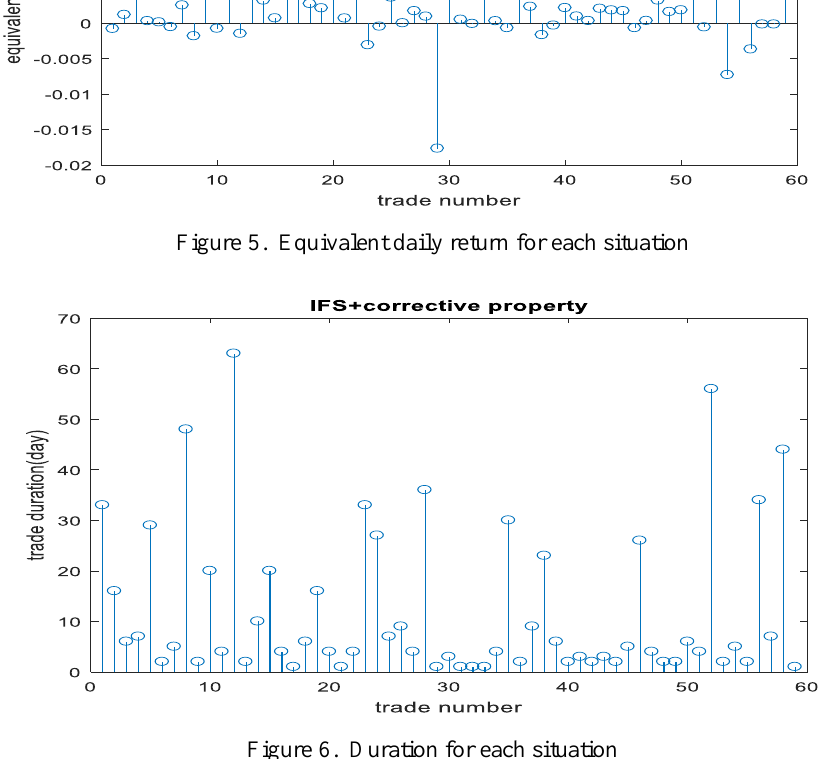
Figure 6. Duration for each